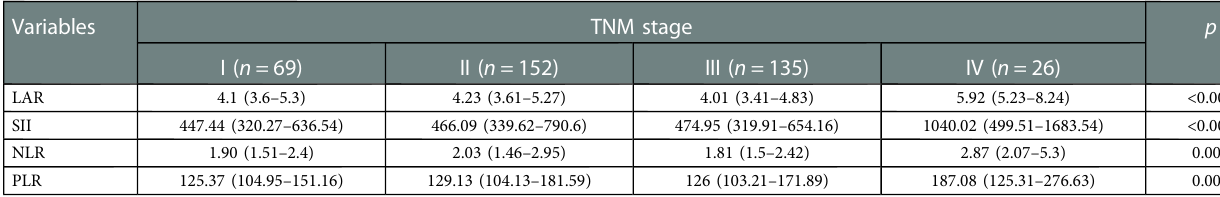
TABLE 2 Correlation between immune-in fl ammatory biomarkers (IIBs) and TNM stage in all CRC patients. Variables TNM stage